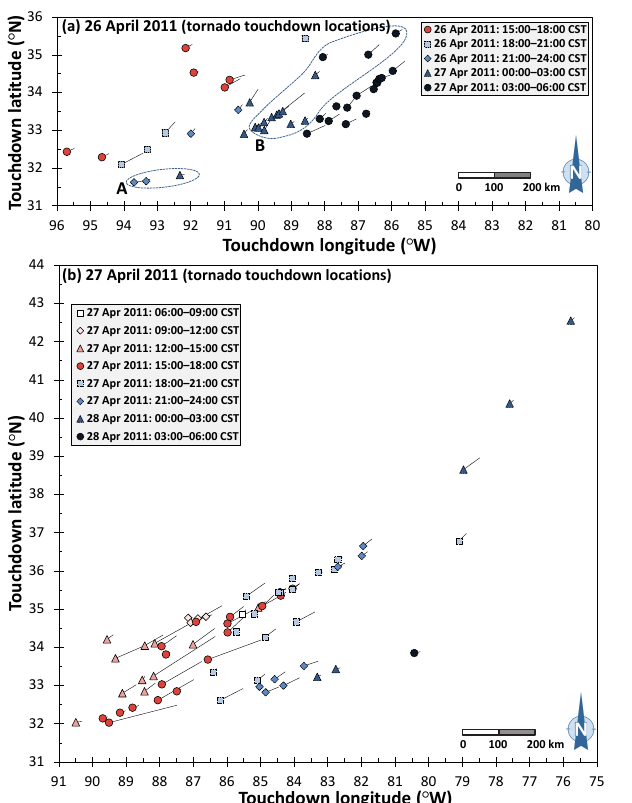
Figure 4. Tornado outbreak on 26–27 April 2011. Spatial– temporal lag correlations between the touchdowns for (a) 45 severe ( L ≥ 10km) tornadoes that occurred on 26 April 2011 (convective day, 06:00–06:00CST) and (b) 64 severe ( L ≥ 10km) tornadoes that occurred on 27 April 2011 (convective day, 06:00–06:00CST). The spatial lag d is plotted against the temporal lag τ for each of the (a) N P = 990 pairs of tornado touchdowns and (b) N P = 2016 pairs of tornado touchdowns. So that (a) and (b) have the same spatial– temporal limits, 147 (7%) of the 2016 data points for (b) that have large spatial or temporal values are not included. The data points in Region AB in (a) are correlations between the spatial–temporal lags for the tornadoes in Region A and Region B in Fig.